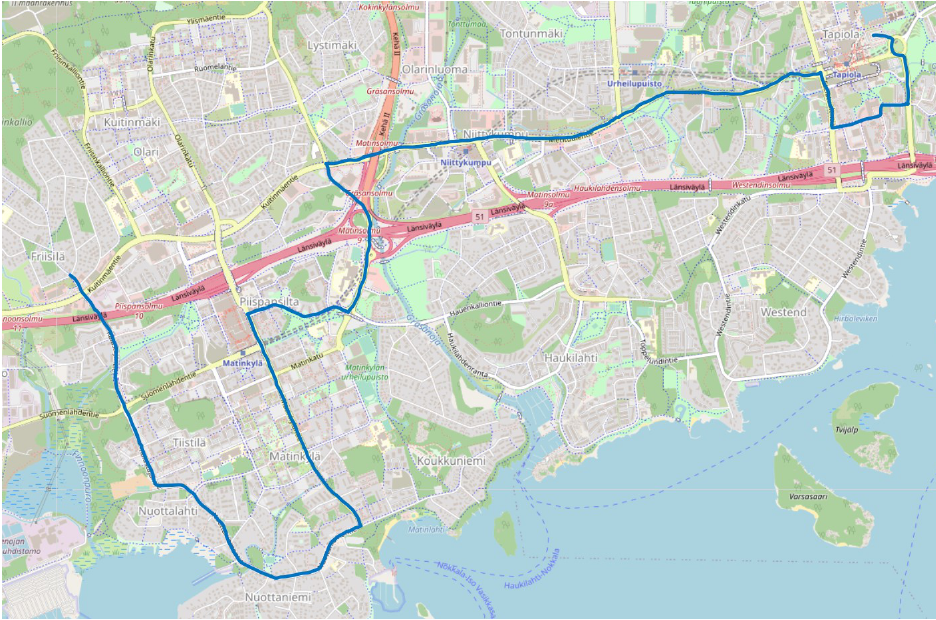
Figure 1. Bus line 11 in Espoo, Finland (Map data c (cid:13) 2020